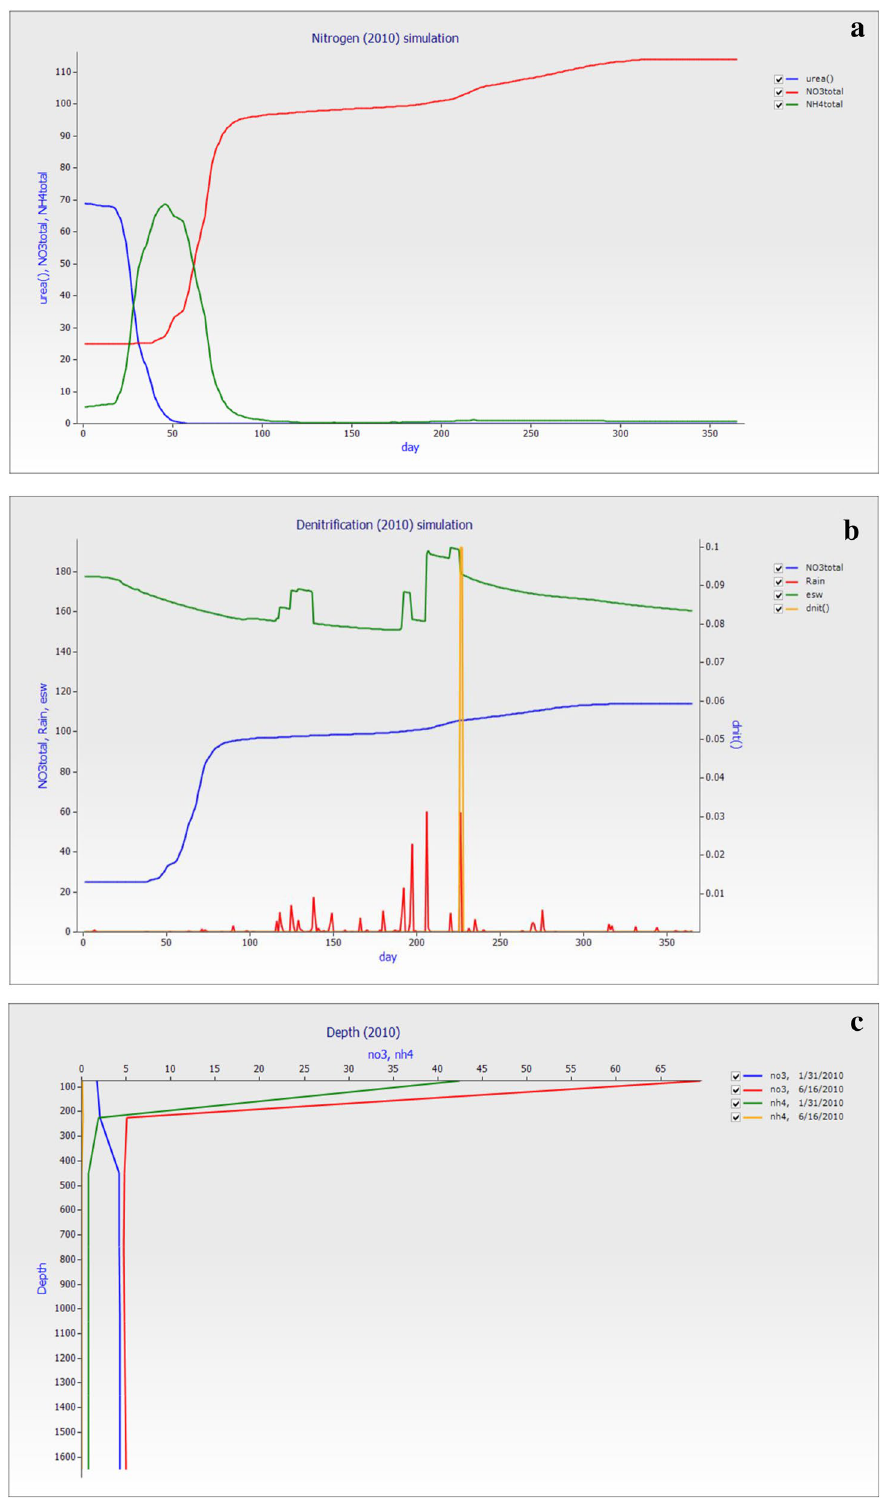
Figure 11. The graph was generated on simulated data for the year 2010 ( a ). The soil nitrogen Total (NO 3− –N and NH 4+ –N) and urea versus day. ( b ) The denitrification (dnit), rainfall, esw, and total NO 3− –N versus days of the year’s while ( c ) The depth of the soil profile NO 3− –N and NH 4+ –N with two different dates of the